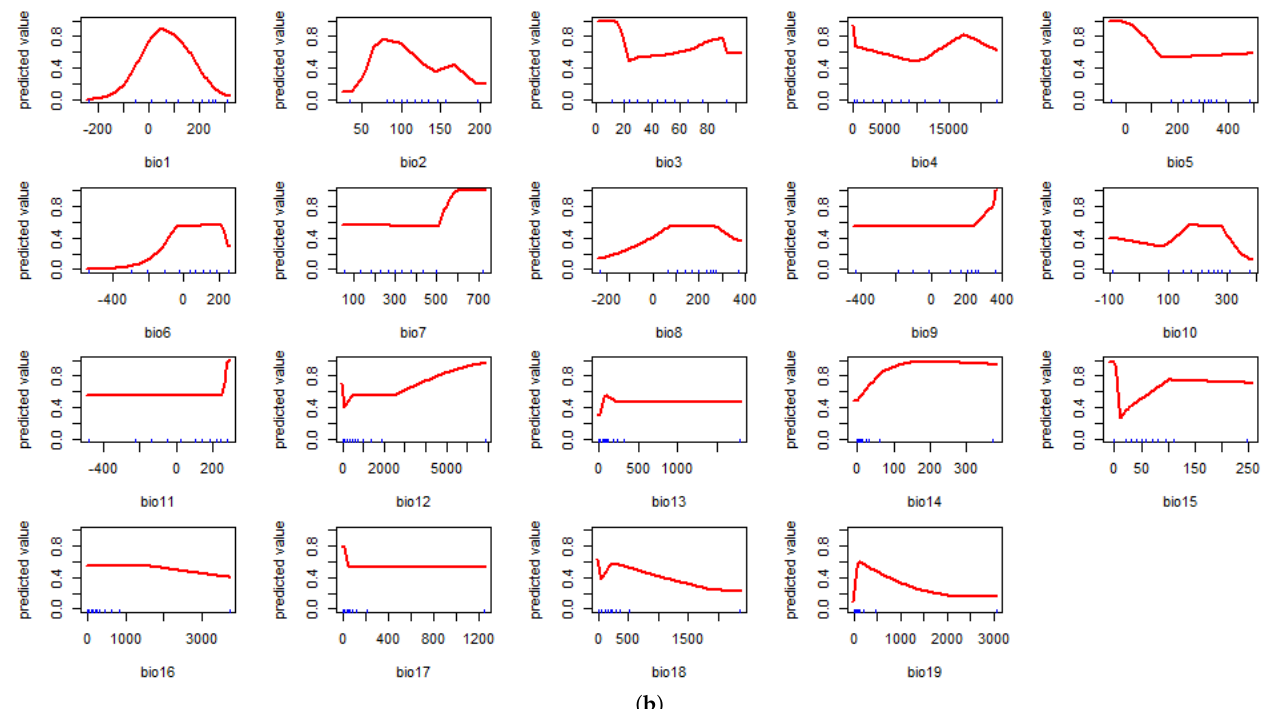
Figure A1. Response curves for the 19 predictors for ME. ( a ) BTD data and ( b ) IBR data. The y-axis presents the predicted probability of the presence of IBR, and the scaled value for the predictors is presented on the x-axis ( × 10).